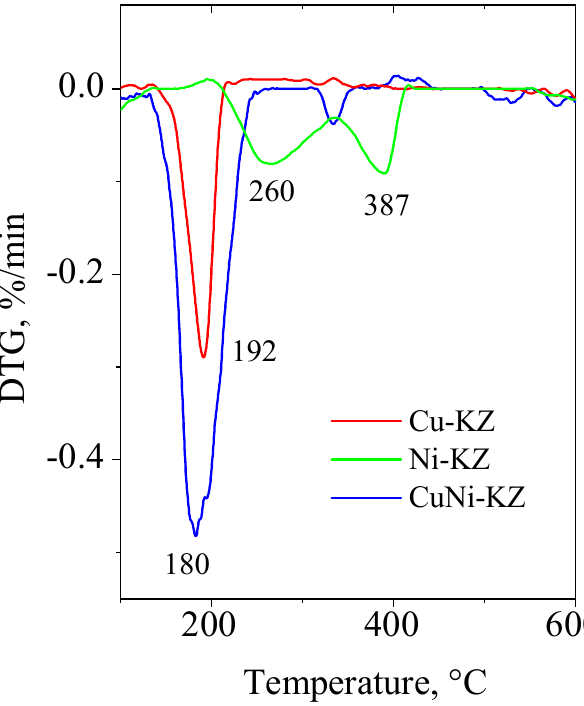
Figure 8. TPR-TG profiles of the studied catalysts.